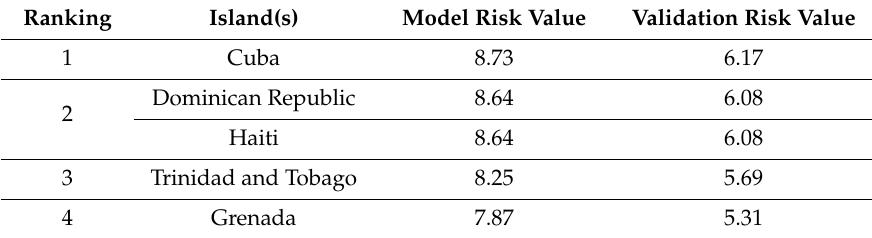
Table 3. Risk values from the risk model and validation model of islands with a documented occurrence of rabid bats.